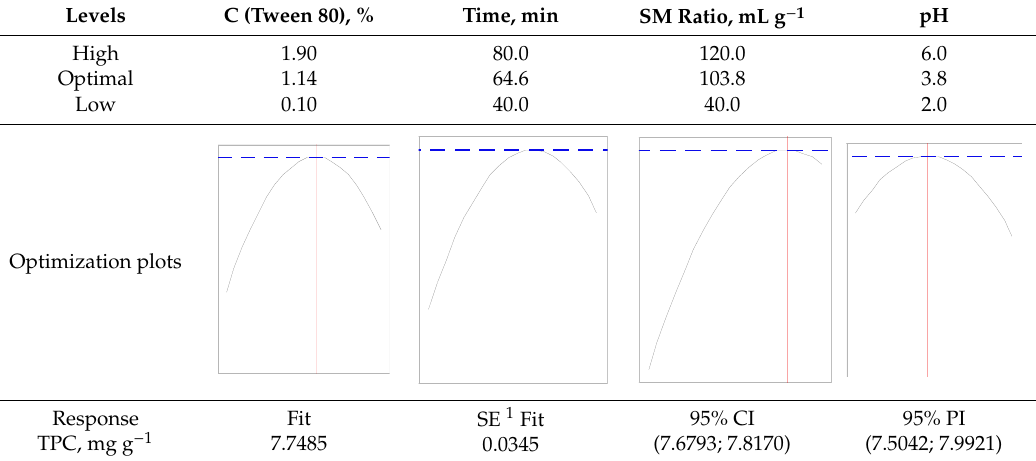
Table 4. Optimal parameters for maximum extraction yield of phenolic compounds from apple pomace. Levels